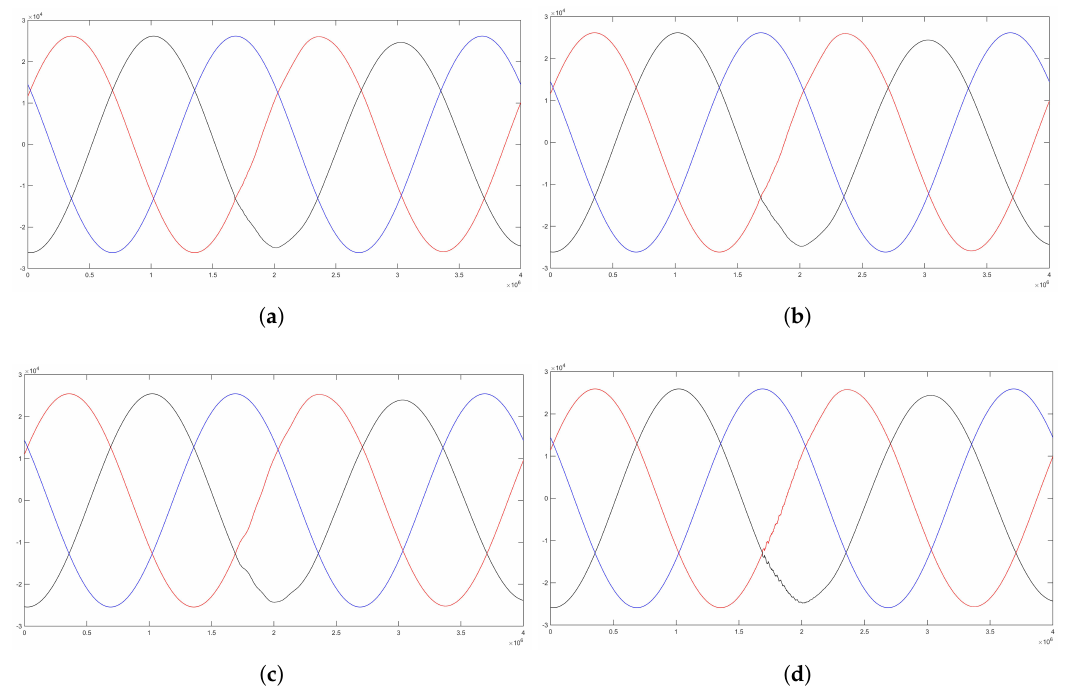
Figure 8. Single phase to ground (BG) fault with 85 Ω placed between Nodes 2 and 3 in the balanced configuration. ( a ) Three phase fault voltages recorded from Node 2. ( b ) Three phase fault voltages recorded from Node 3. ( c ) Three phase fault voltages recorded from Node 4. ( d ) Three phase fault voltages recorded from Node